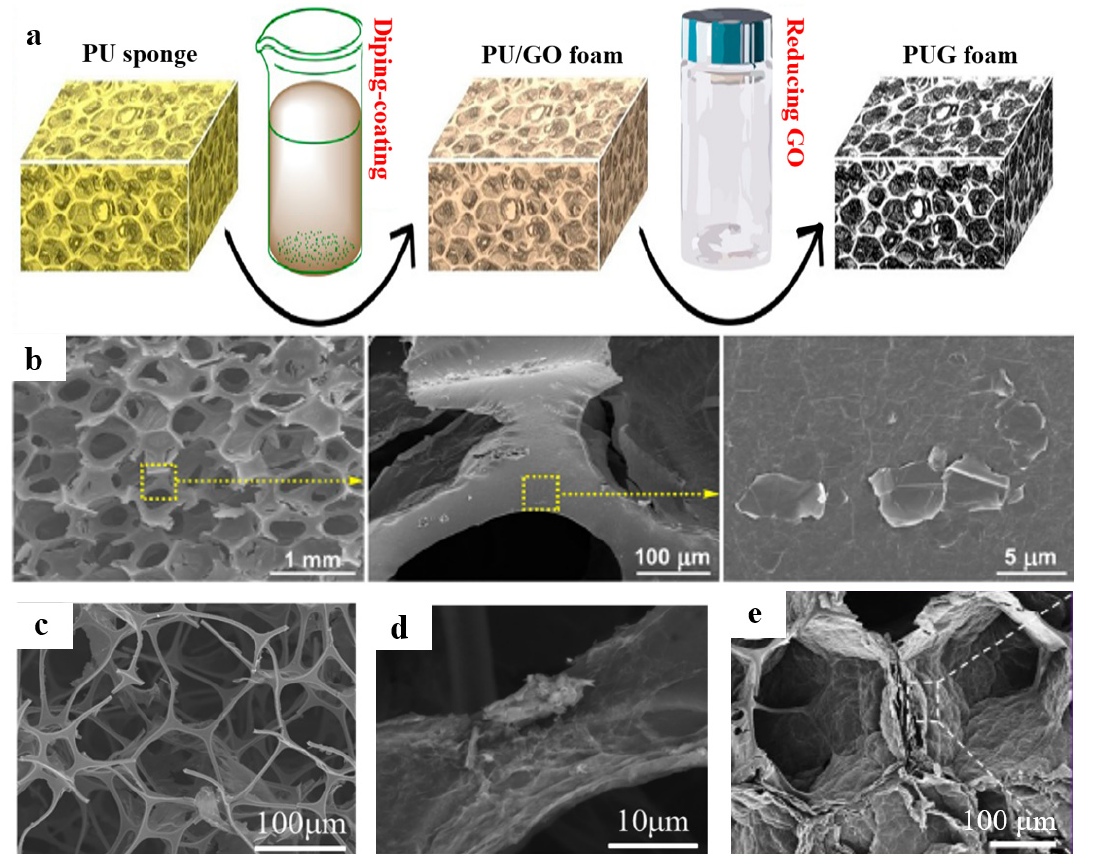
Figure 5. ( a ) Fabrication process of the PUG foam. ( b ) The SEM images of the PUG foam. Reproduced with permission from [64]. ( c , d ) The SEM images of ODA-RGO@MF foam. Reproduced with permission from [65]. ( e ) The microstructure of PFGA. Reproduced with permission from [66].